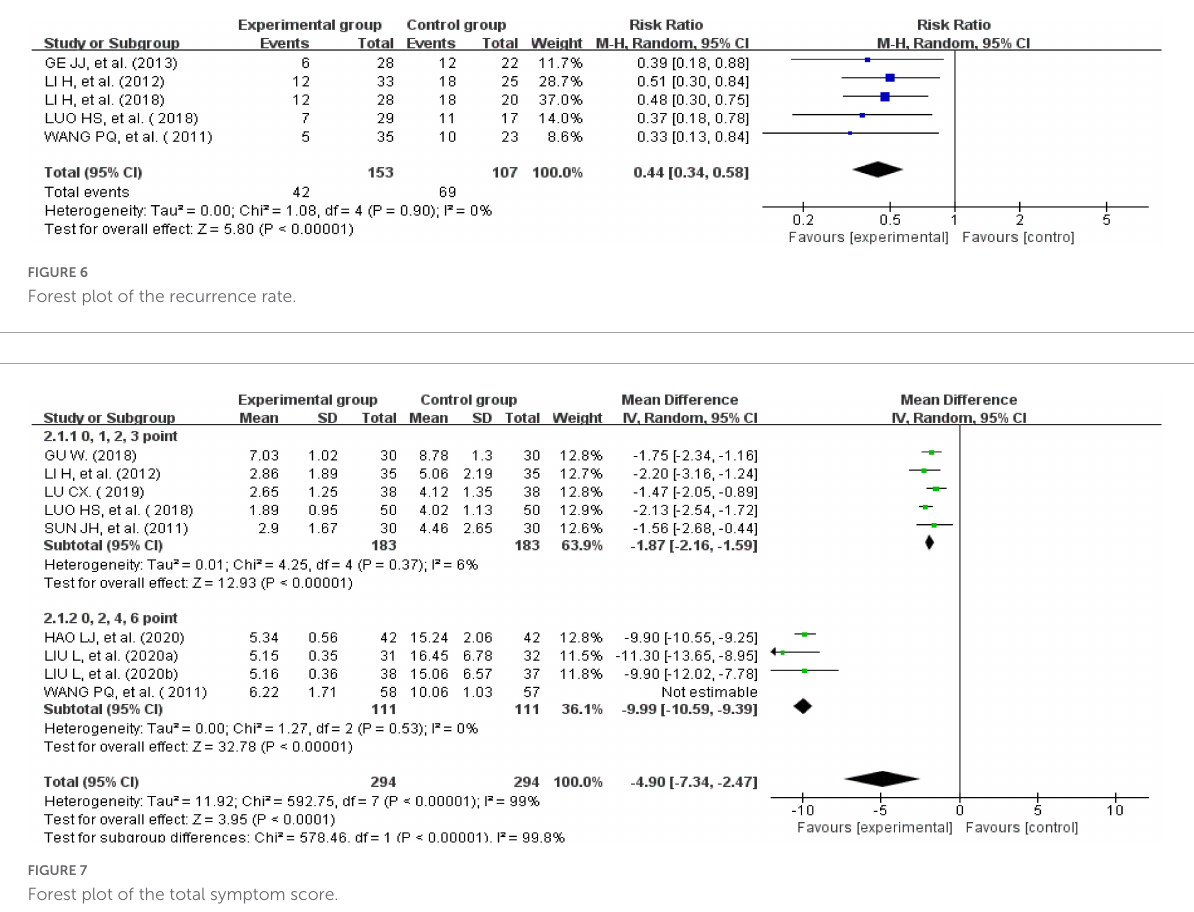
( Figure 9 ). A subgroup analysis based on intervention measures and duration showed decreased heterogeneity, but I 2 was still >